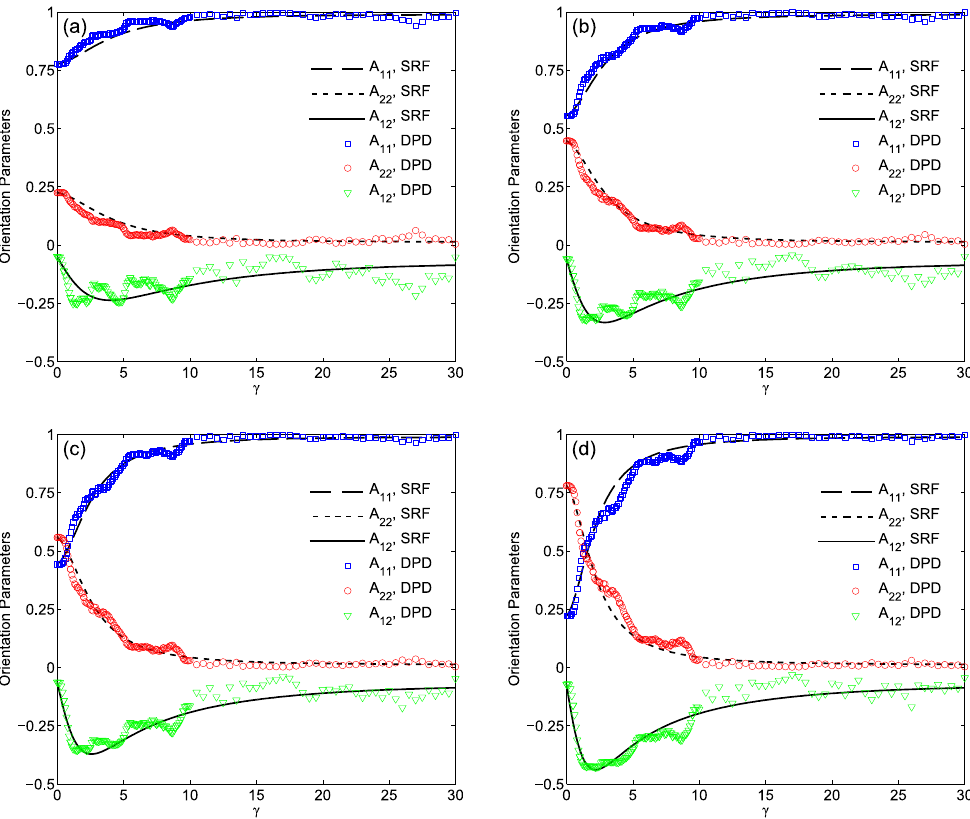
Figure 19. The orientation process defined by the orientation parameters as a function of the shear strain, γ . The results are derived from DPD models and strain reduction factor (SRF) model for various average initial orientation angles of ( a ) 20.16 ° ; ( b ) 40.32 ° ; ( c ) 50.40 ° ; and ( d ) 70.56 ° . Reprinted from Gooneie et al. [196]. Copyright 2016, with permission from John Wiley & Sons Inc.